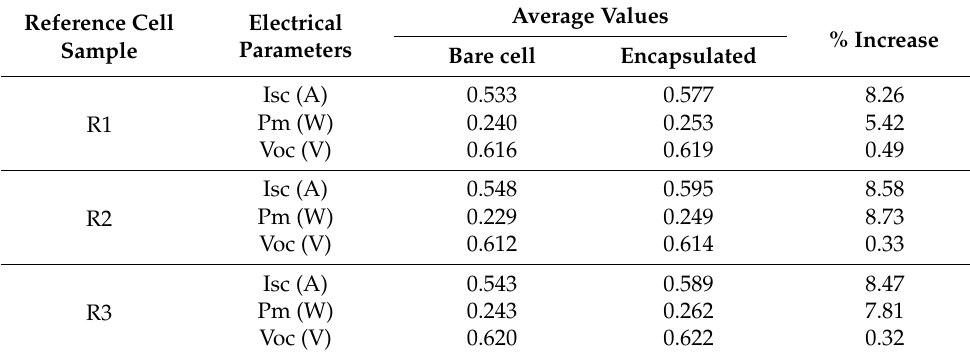
Table 4. Electrical parameters of three reference samples before and after encapsulation.